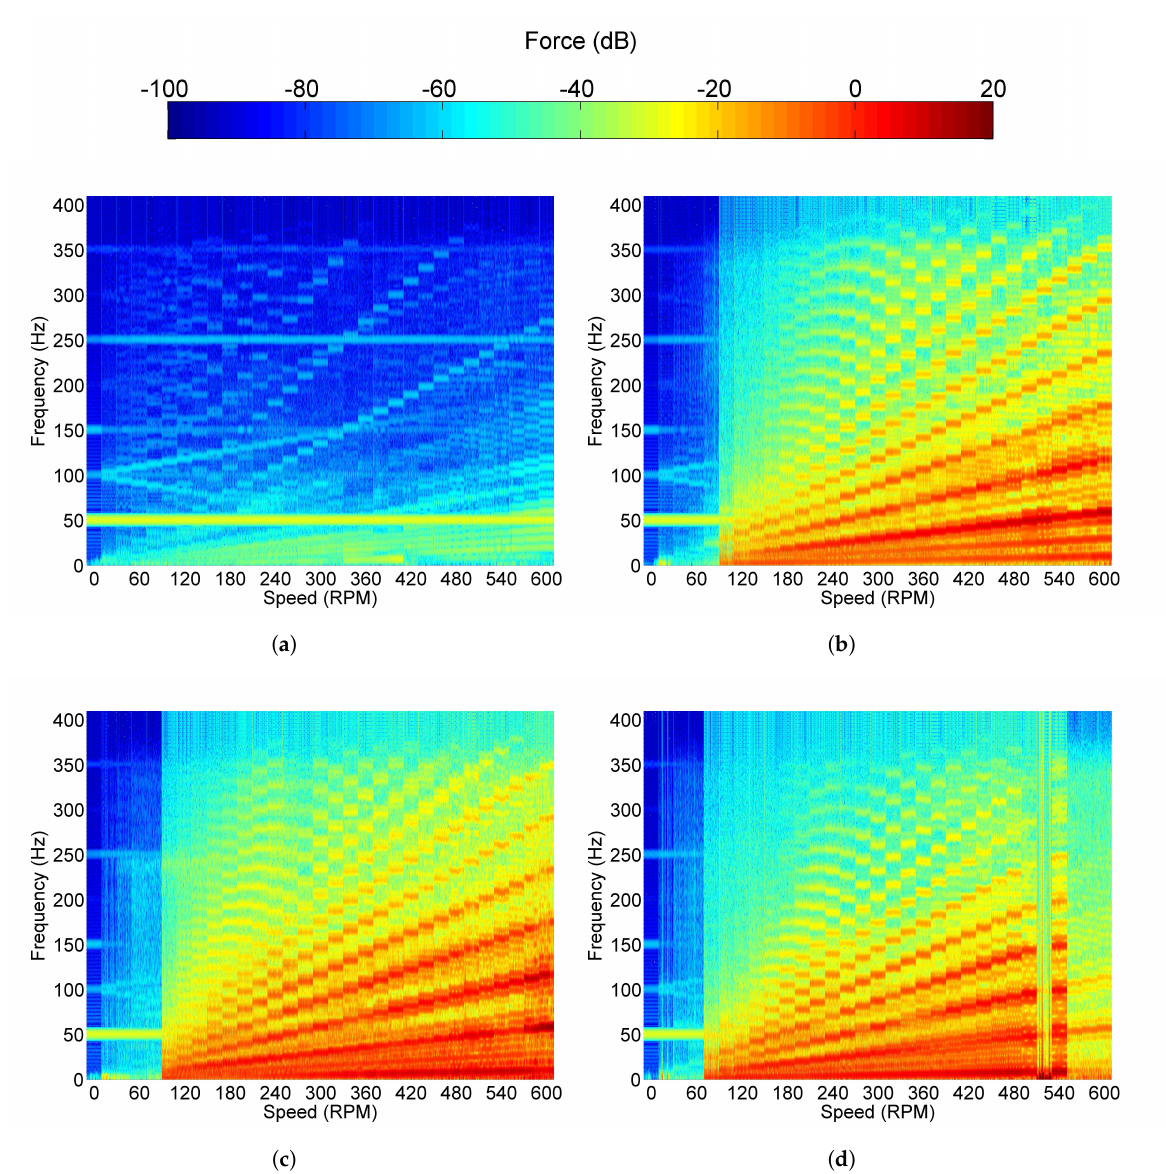
Figure 8. Spectrograms of the PVDF output with: ( a ) of the shaft alone; ( b ) the two-blade propeller; ( c ) the brass two-blade propeller and ( d ) three-blade propeller is attached using the six pad